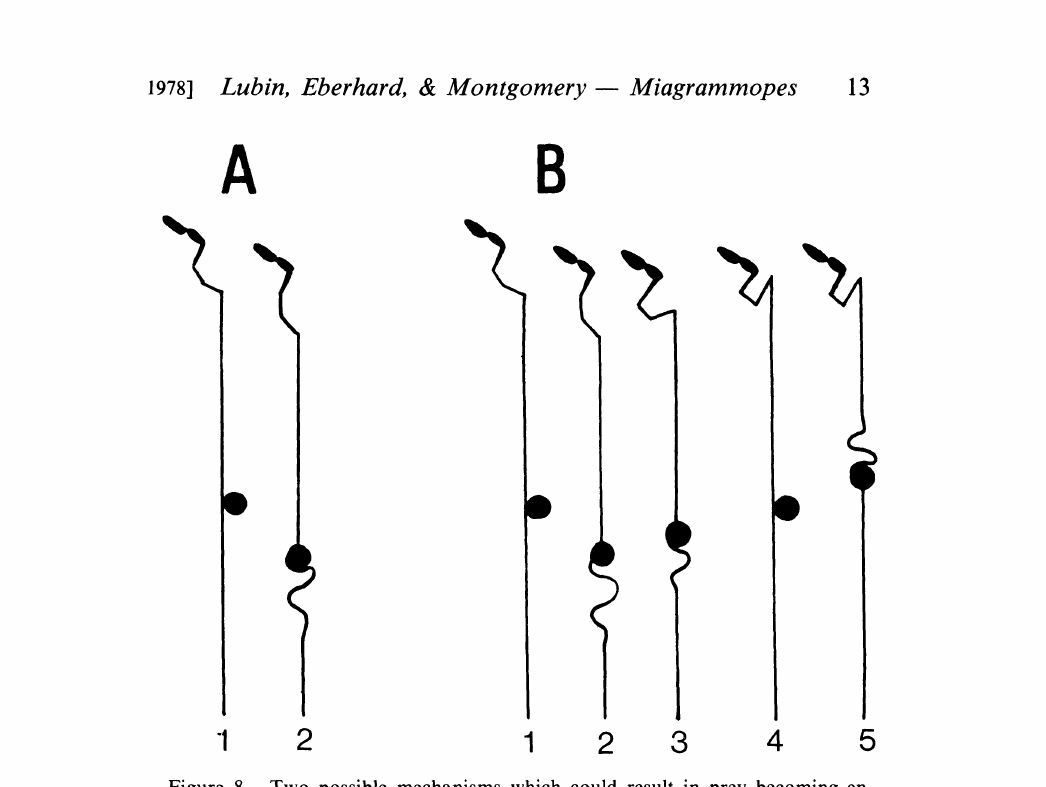
Figure 8. Two possible mechanisms which could result in prey becoming en- tangled as a result of sagging behavior. A) The prey drops faster than the line below it, and thus becomes entangled. B) The prey’s momentum, acquired when the spider jerks the line up after a sag, causes it to become entangled in the line just above it. This hypothesis depends on the thread below the prey being extensible. on four occasions. Each time the spider jerked and sagged the cap- ture thread several times, ran a short distance down the capture thread, wadding it up as it went, and then cut the line above the ant and ran back up to the resting thread. These ants were thus recog- nized from a distance, perhaps by their strong alarm odor. After an ant was rejected, the wadded-up section of the capture thread was manipulated in the mouthparts for several minutes (feeding?), then dropped. Rejection of prey thus resulted in destruction of the capture thread. A new thread was often built within a few hours. Three other ants, two Camponotus sp. and one Ectatoma sp., all about the same size as the spider (6-7 mm long), were attacked successfully, but modifications of the capture sequence occurred in all three trials. In two, the spider dropped the lower portion of